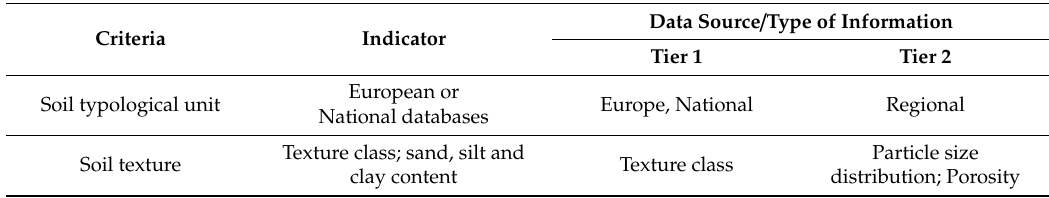
Table 1. Common criteria for risk area identification according to soil threats considering a